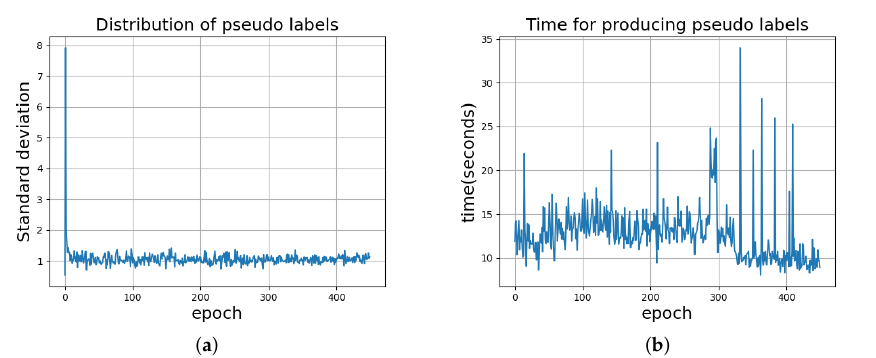
Figure 7. For k = 3000 and 450 epochs on AlexNet, the standard deviation of pseudo-labels and time for convergence at every epoch: ( a ) the very small values of standard deviation means that the distribution of pseudo-labels is very uniform; ( b ) the average time to produce these labels is 12.68 s on